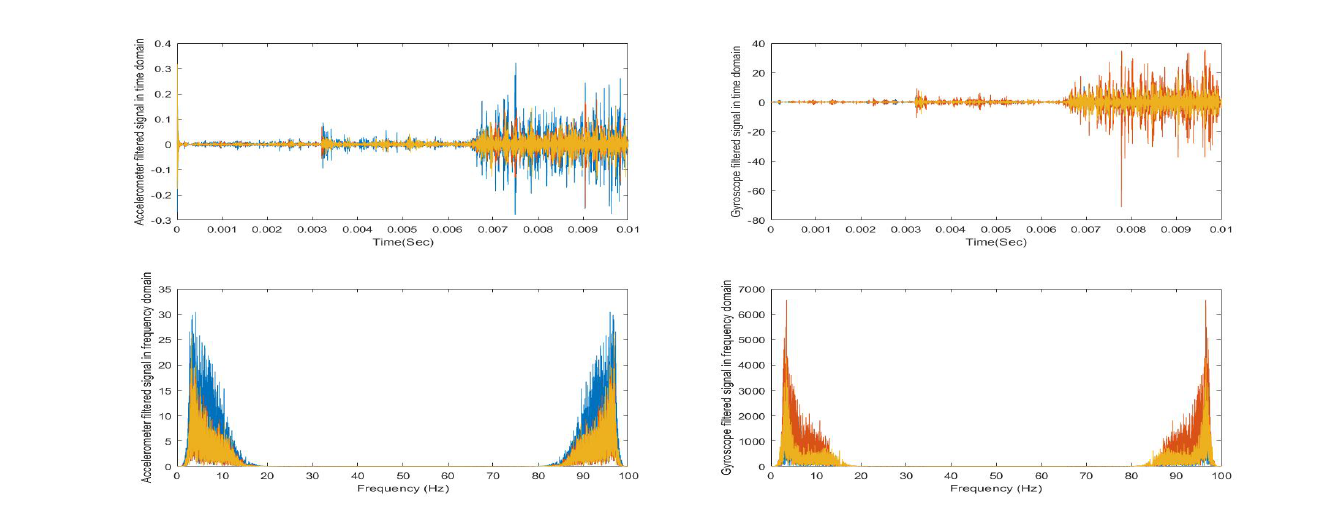
Figure 6. Visualization of healthy control signals before and after filtering in time and frequency